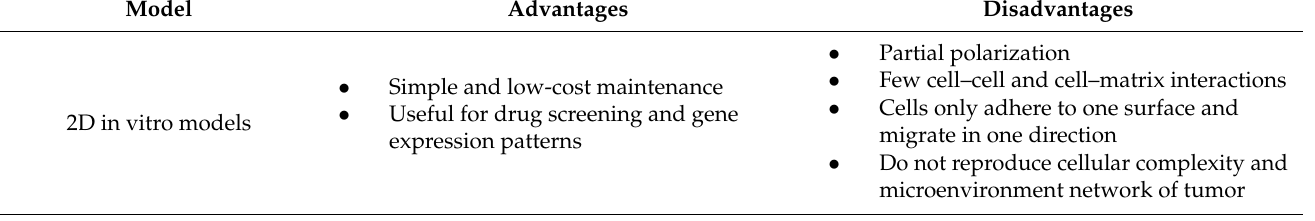
Table 1. Pros and cons of 2D and 3D in vitro and in vivo cancer models.